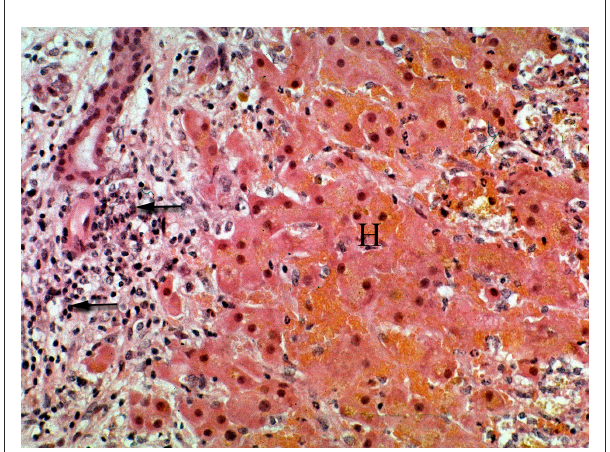
FIGURE10 Photomicrograph of a liver from horse treated with ground, dried hounds tongue ( Cynoglossum officinale ) to obtain a dose of 15mg total dehydropyrrolizidine alkaloids/kg BW for 9 days. The horse developed liver failure and was euthanized and necropsied. Notice the focally extensive hemorrhagic necrosis (H) that is characterized by the replacement of hepatic cords with erythrocytes and cellular debris. This reaction is both centrilobular and midzonal. No central vein is seen in this section. The periportal region is infiltrated with numerous lymphocytes mixed with proliferating ovalocytes and fibroblasts. Some ovalocytes are beginning to form rows and small tubules (biliary proliferation). Figure modified from previous publication